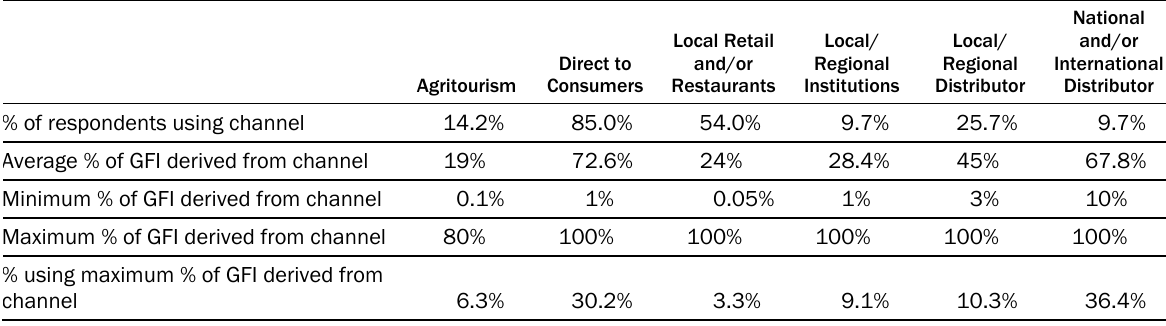
Table 3. Contribution of Marketing Channels to Gross Farm Income